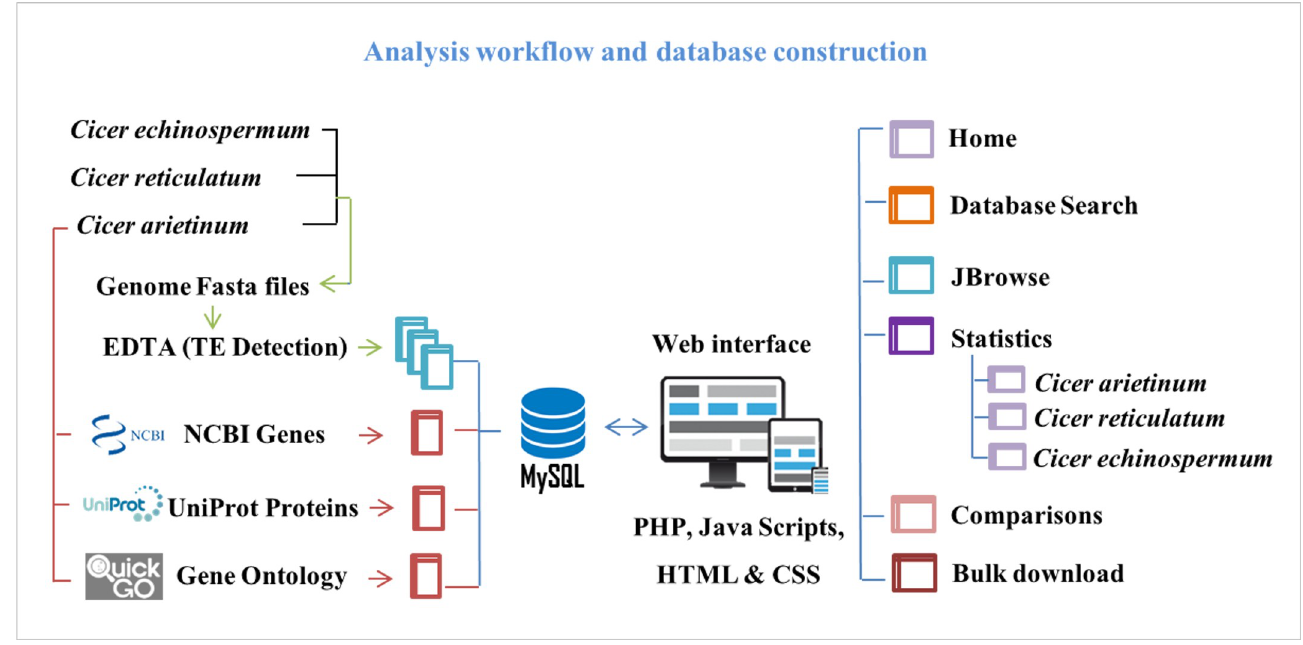
Fig 1. The overall framework used for identifying and characterizing TEs in Cicer species and the steps involved in creating CicerSpTEdb.